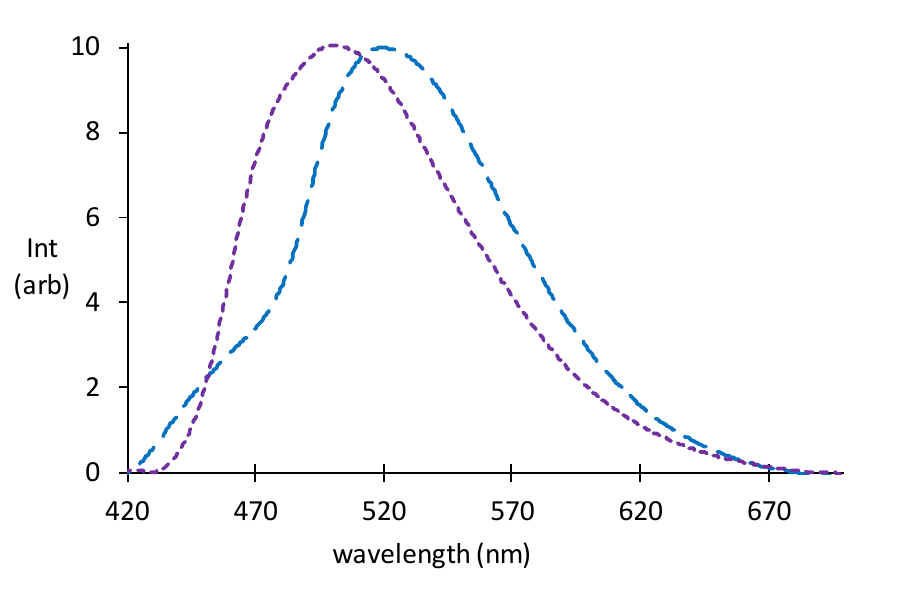
Figure 3. Normalized fluorescence of pyridinones 10a and 10b in ethanol ( 10a (H), — — ; 10b (F), – – – ).